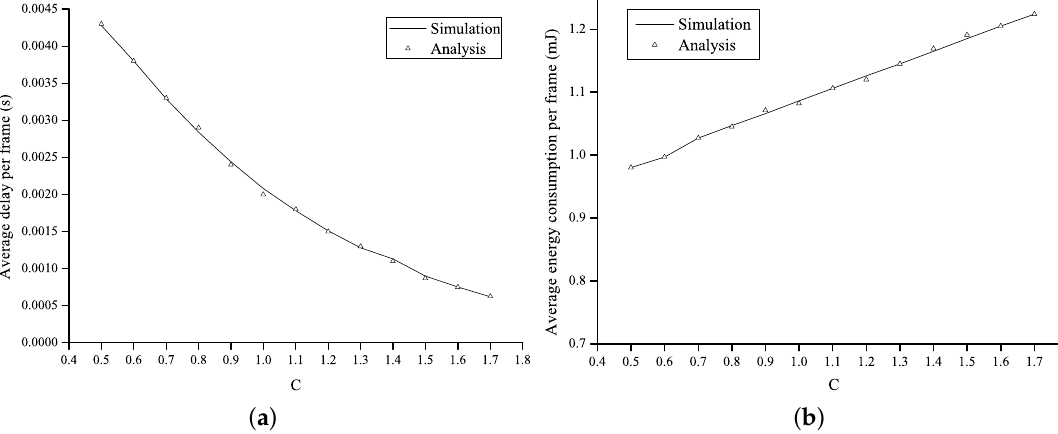
Figure 6. Performance of the proposed method. ( a ) average delay per frame; and ( b ) average energy consumption per